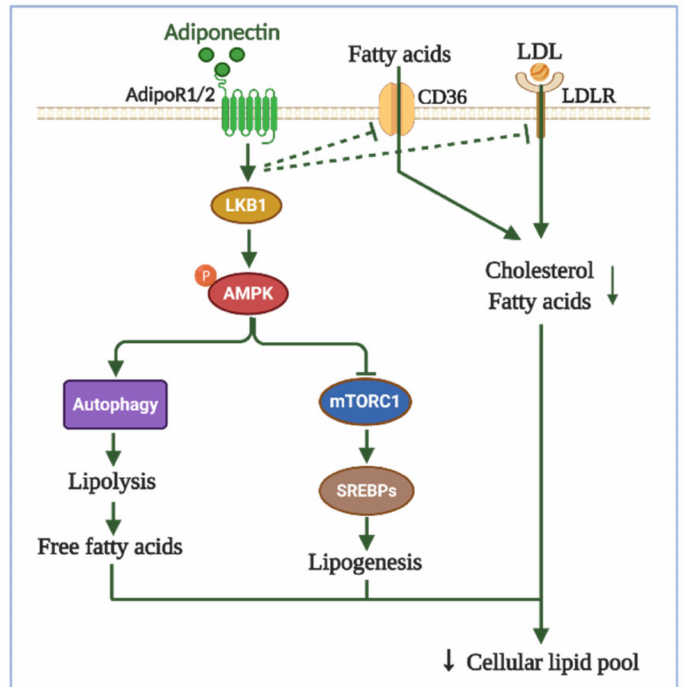
Figure 3. The putative roles of adiponectin in cancer-related lipid metabolic alterations. Adiponectin- driven signaling pathways have been implicated in regulation of lipid metabolism. Adiponectin has been reported to suppress SREBPs-dependent lipogenesis through inactivation of mTORC1, an upstream modulator of SREBPs and de novo lipid biosynthesis. Moreover, adiponectin downreg- ulates expression of CD36 and LDLR, membrane proteins playing an important role in import of exogenous fatty acids and cholesterol, and thereby decreases uptake of lipids from tumor microen- vironment. Since adiponectin has been well known as an activator of autophagy, it is speculated that adiponectin induces lipolysis and lipid degradation via β -fatty acid oxidation. Collectively, these effects may lead to impaired reservation of intracellular lipid that in turn possibly causes disruption of membrane structure and interruption of lipid-based signaling pathways. However, the role of adiponectin-promoted lipid metabolic changes remains to be further elucidated. AdipoR1/2: adiponectin receptor 1/2, CD36: cluster of differentiation 36, LDL: low-density lipoprotein, LDLR: the low-density lipoprotein receptor, mTORC1: mammalian target of rapamycin complex 1, SREBPs: sterol regulatory element-binding